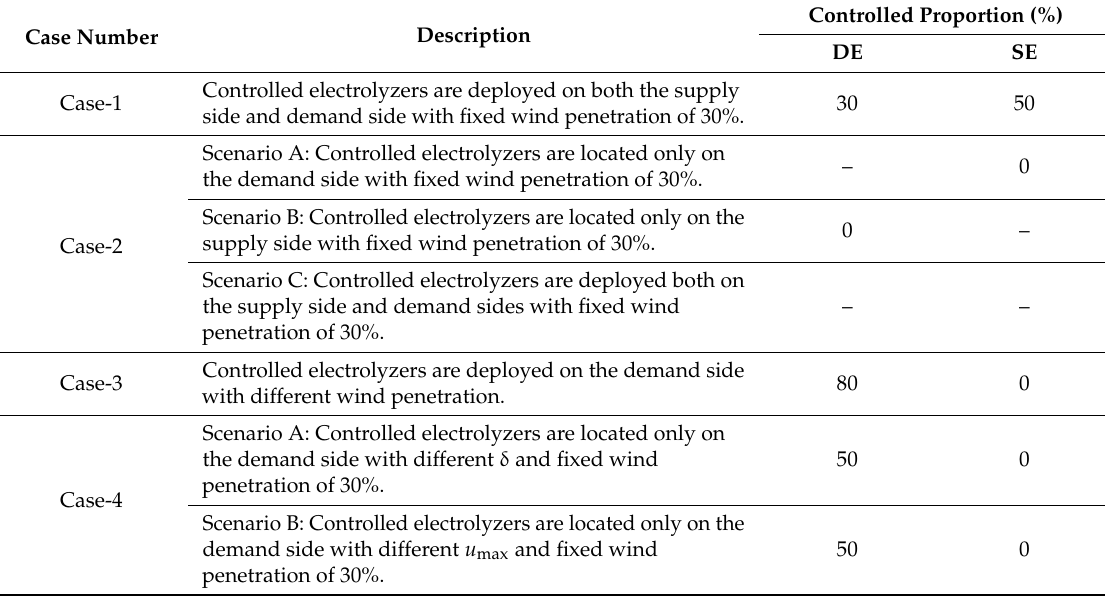
Table 1. Brief description of each case study.